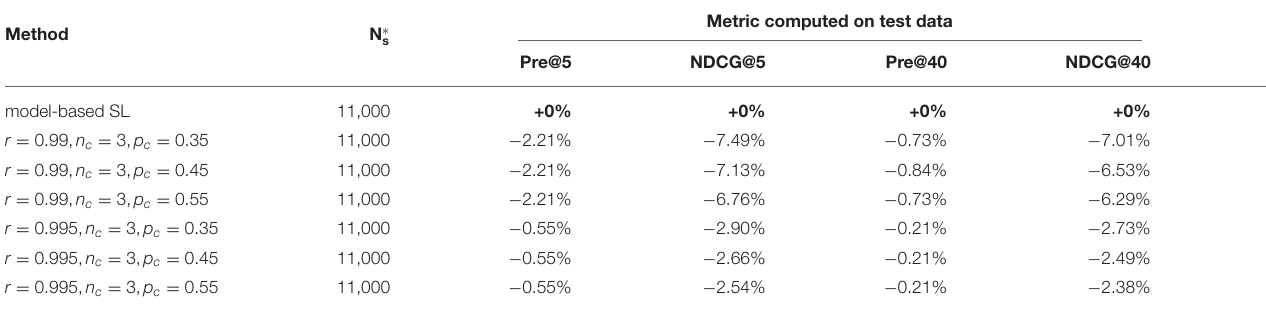
TABLE A2 | Summarization of shortlister models’ performance with collaborative relabeling. Normalized relative difference of each method when compared to baseline method “model-based SL” is presented. Positive values (+) implies that the method outperforms baseline